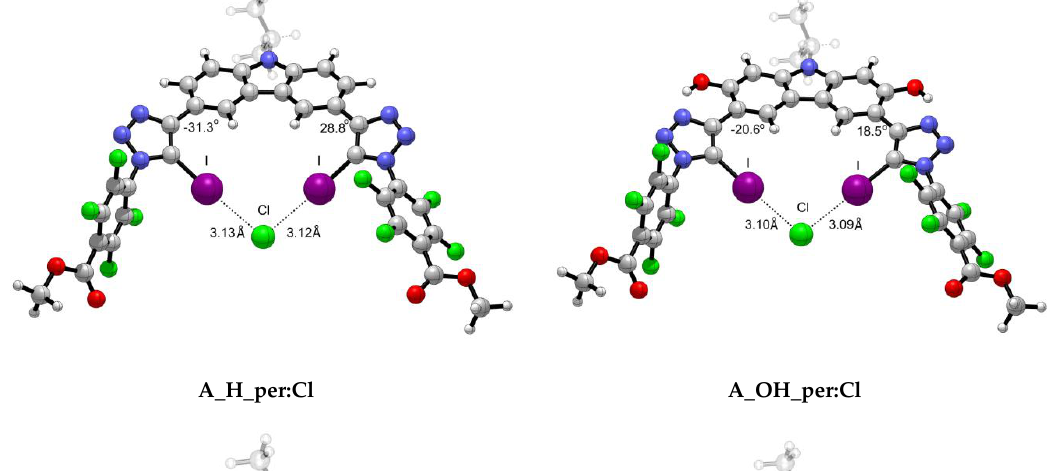
Table 1. Maxima (V max,I ) values of the molecular electrostatic potential (in a.u.) on the 0.001 a.u. electron density isosurface for all the monomers ( A ) calculated at m062x/aug–cc–pVDZ level. Due to the lack of symmetry slight variations are found the two different iodine atoms (1 and 2).